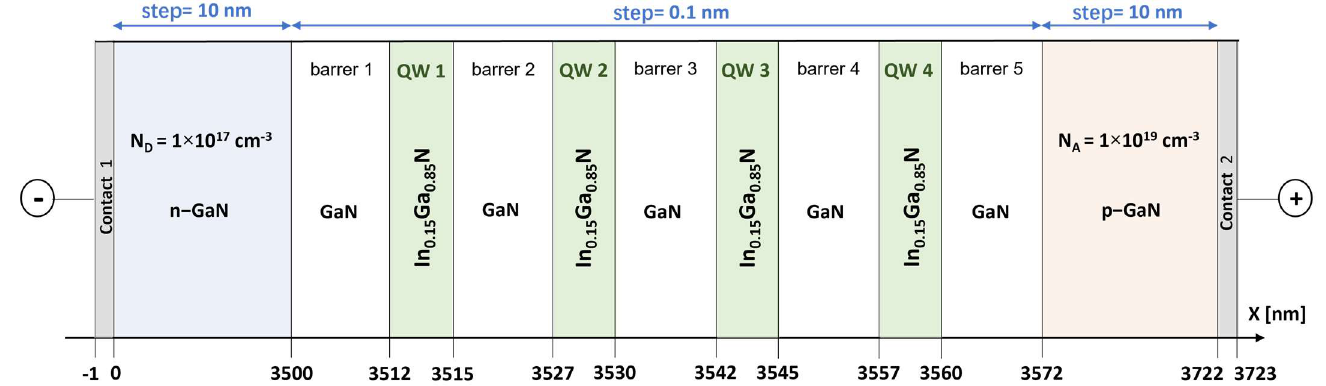
Figure 2. Simulation spatial diagram and parameters for the InGaN/GaN blue LED.